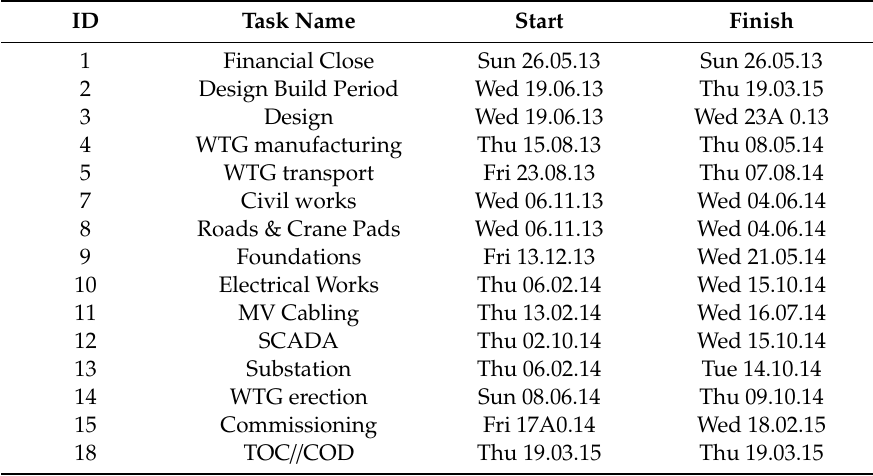
Table A3. Timetable for Construction